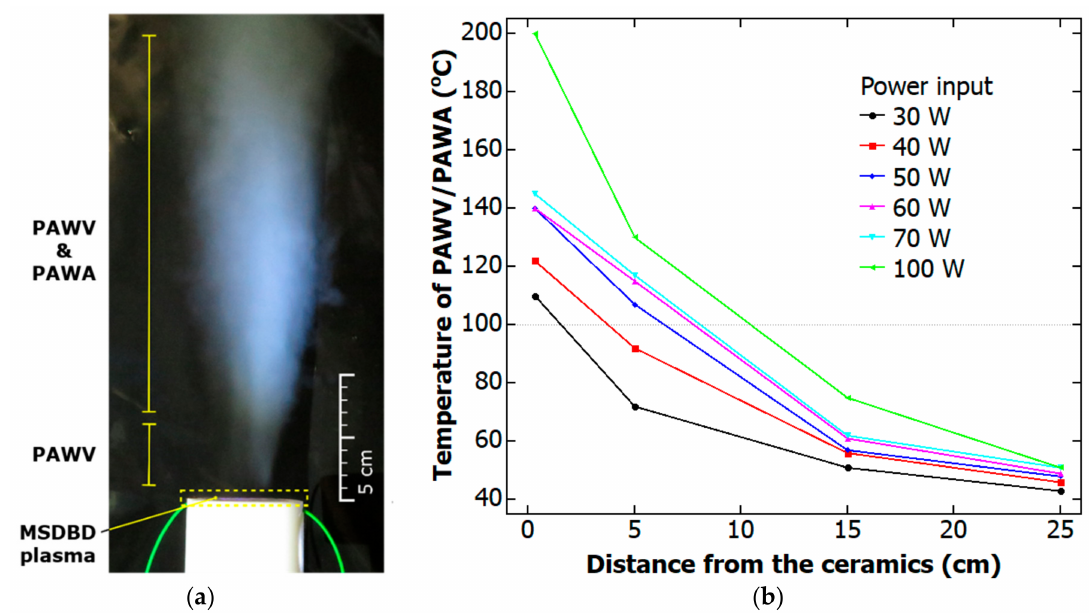
Figure 3. The photograph of MSDBD at the stabilized flow of pure water vapor used for bacteria decontamination ( a ) and the graph of temperature in dependence of distance from ceramics and input power ( b